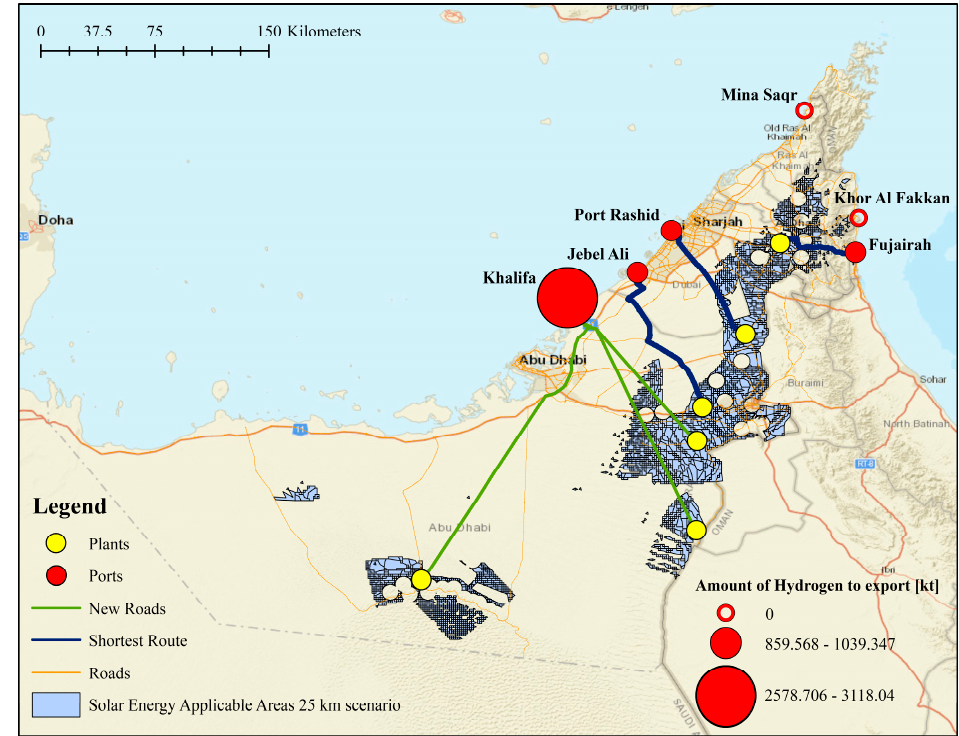
Figure 10. Proposed shortest routes from hydrogen plants to export ports analysis with GIS.